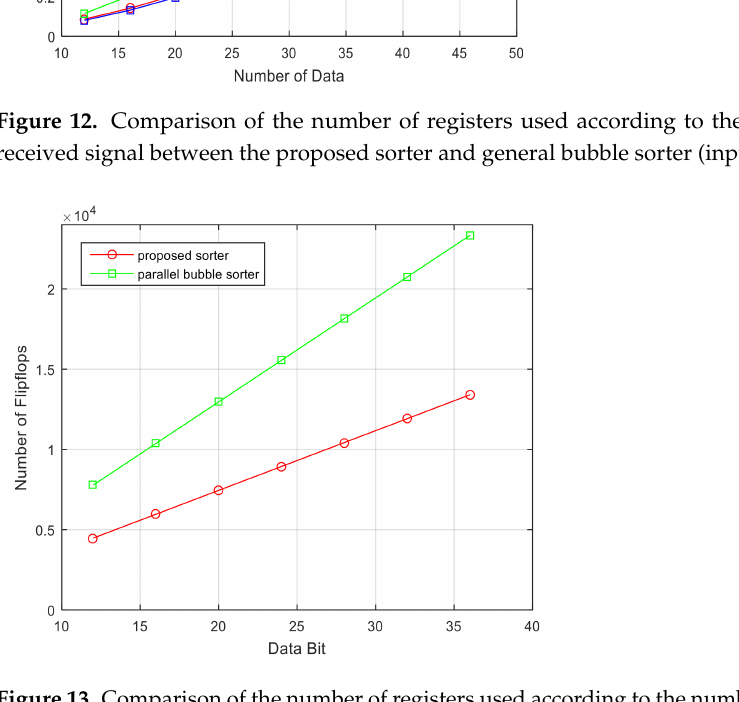
Figure 13. Comparison of the number of registers used according to the number of bits of the received signal between the proposed sorter and general bubble sorter ( N = 36, p =